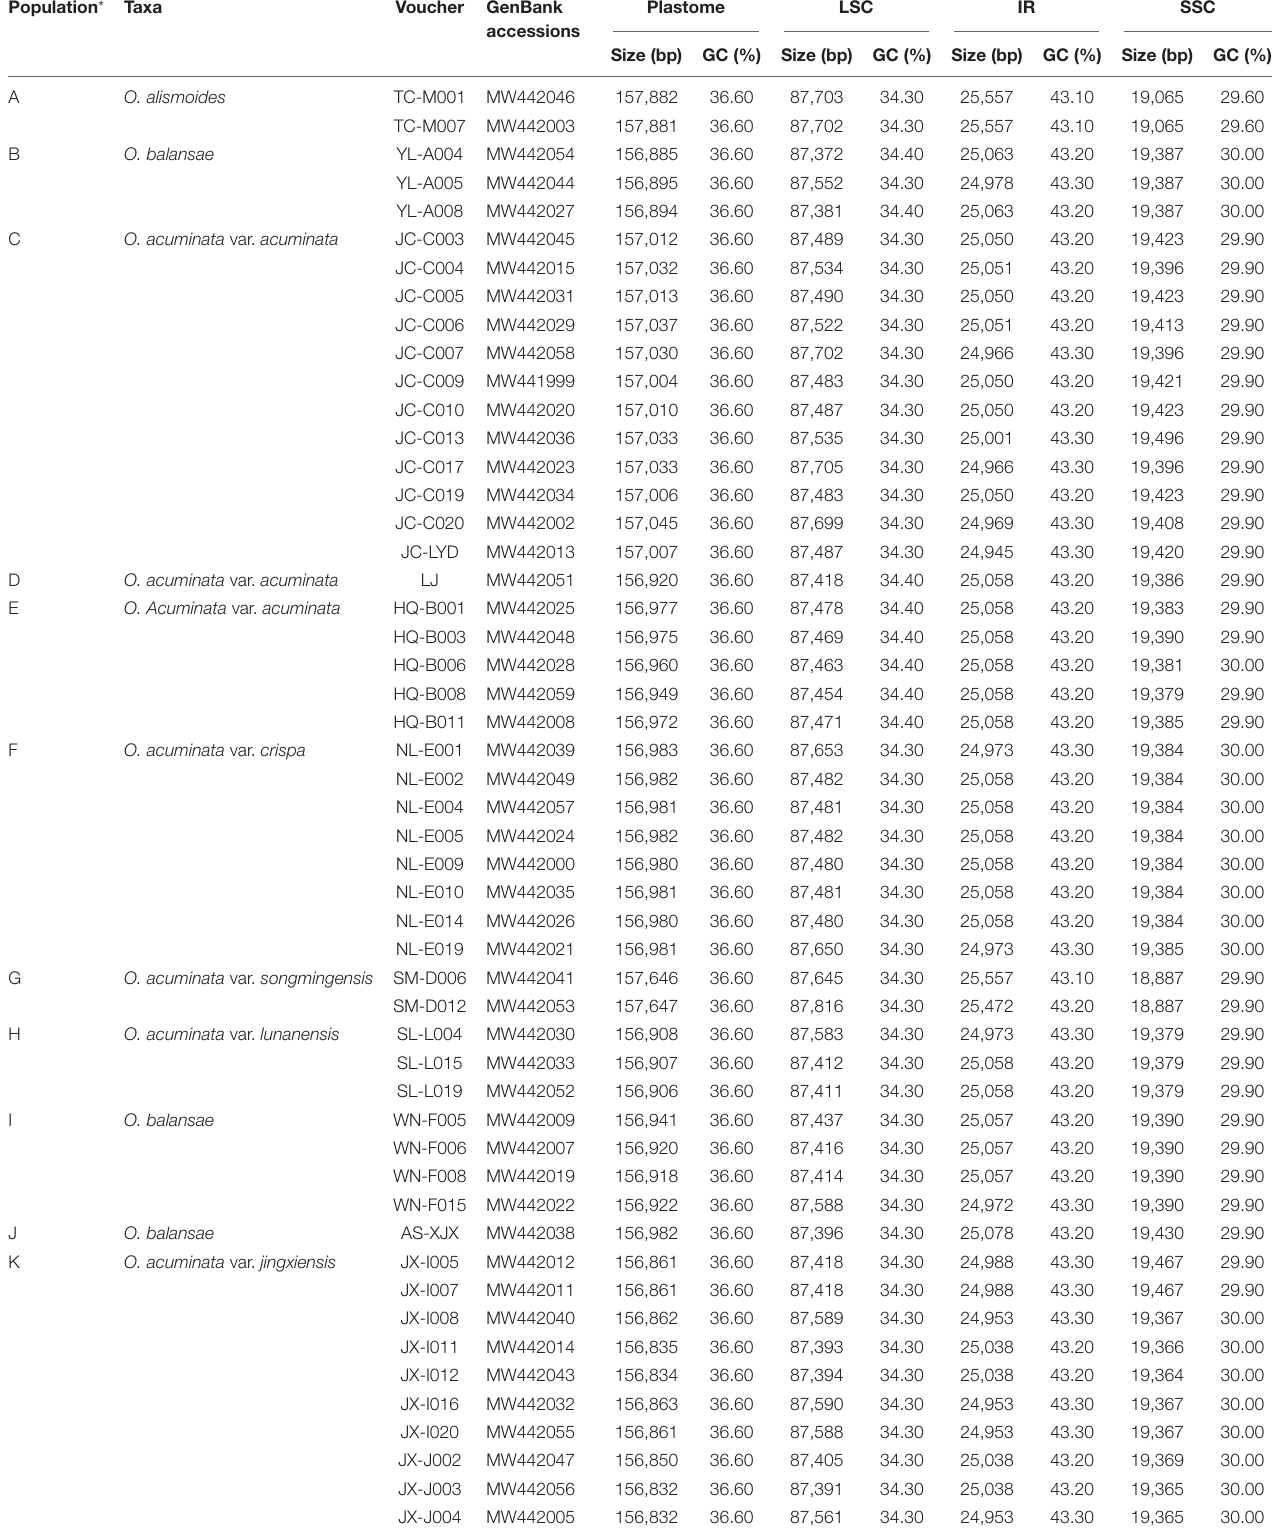
TABLE 1 | Samples used in this study with population, voucher, GenBank accessions, and plastome features. Population * Taxa Voucher GenBank